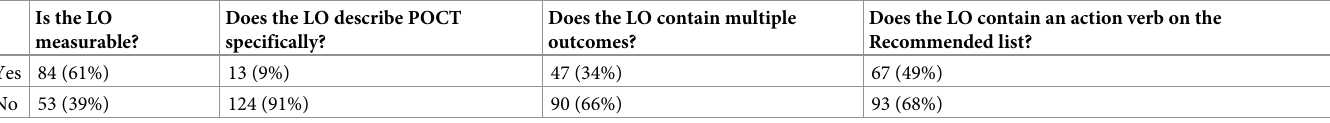
LO: learning outcomes. POCT: point of care